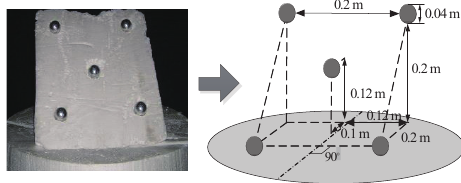
Figure 10. Metallic balls target model.